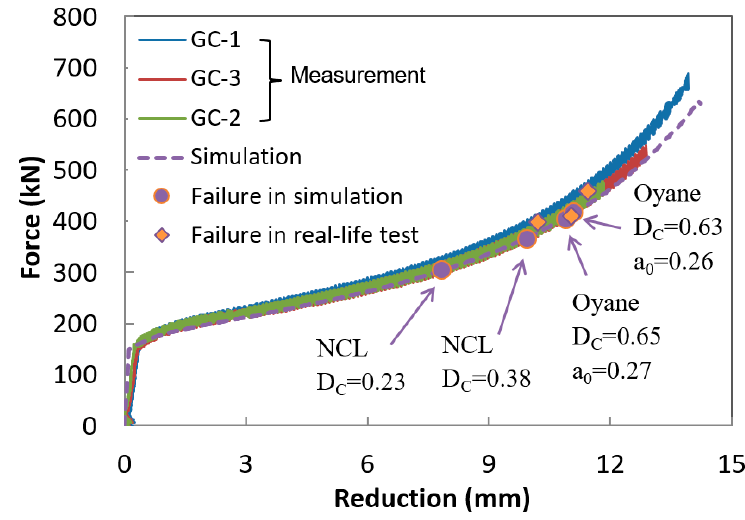
Figure 37. The comparison between measured and simulated compression forces and fracture initiation points for notched cylinder